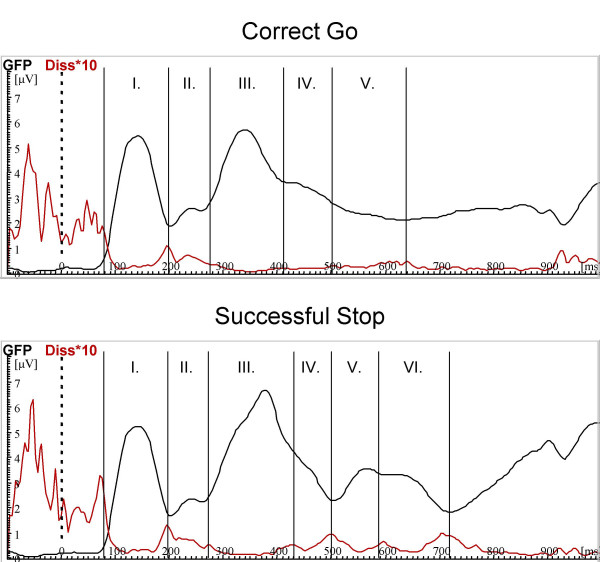
Microstate estimation according to GFP and Diss. Adaptive segmentation of the total groups grand mean from correct Go (top) and successful Stop (bottom). Microstate boarders were determined by relative minima of GFP (black) together with relative maxima in Diss (red, for better scaling multiplicated with 10) Correct Go-trials revealed five microstates (76–196 ms, 200–272 ms, 276–412 ms, 416–504 ms, 508–640 ms), successful Stops six microstates (76–196 ms, 200–272 ms, 276–428 ms, 432–504 ms, 508–592 ms, 596–724 ms).